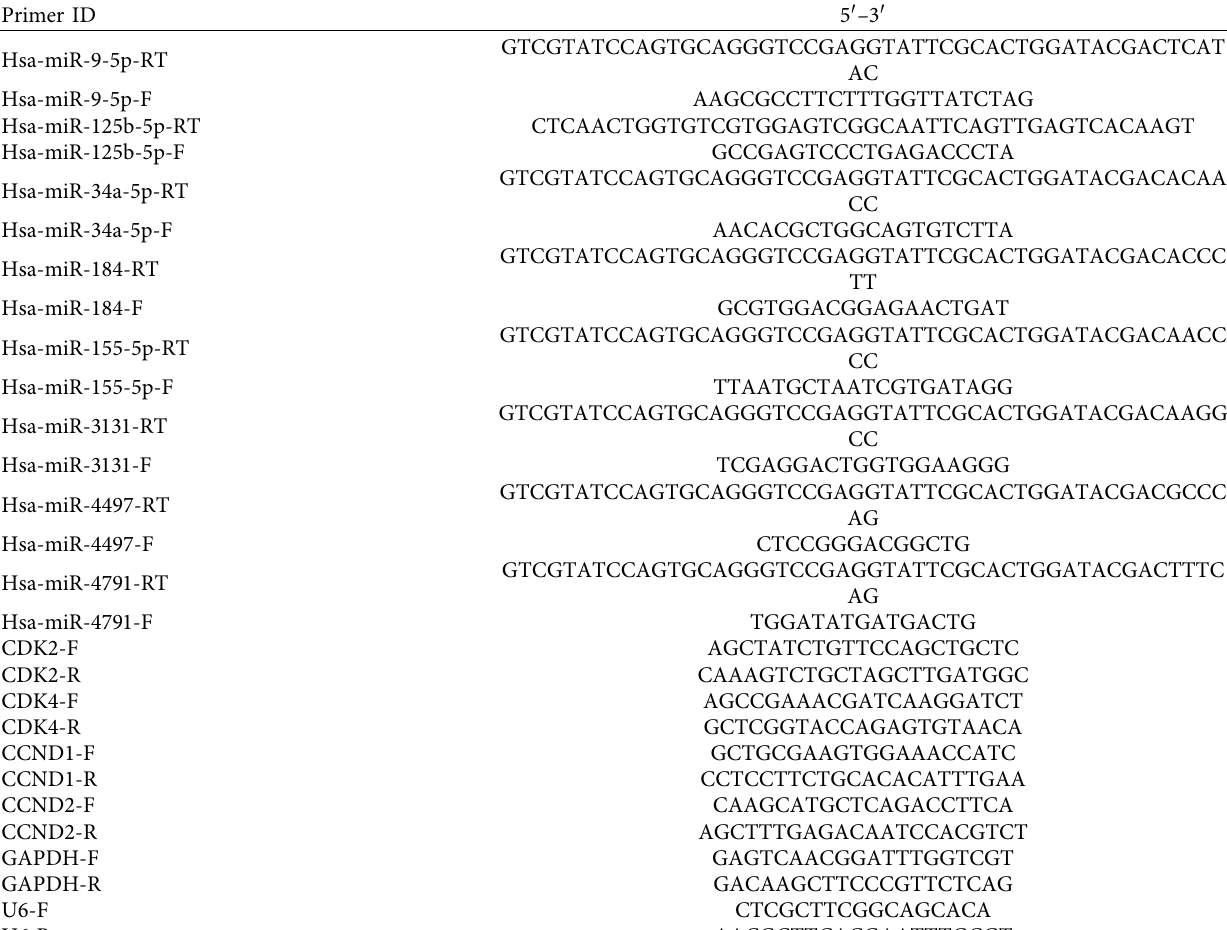
Table 1: Te primers used in this